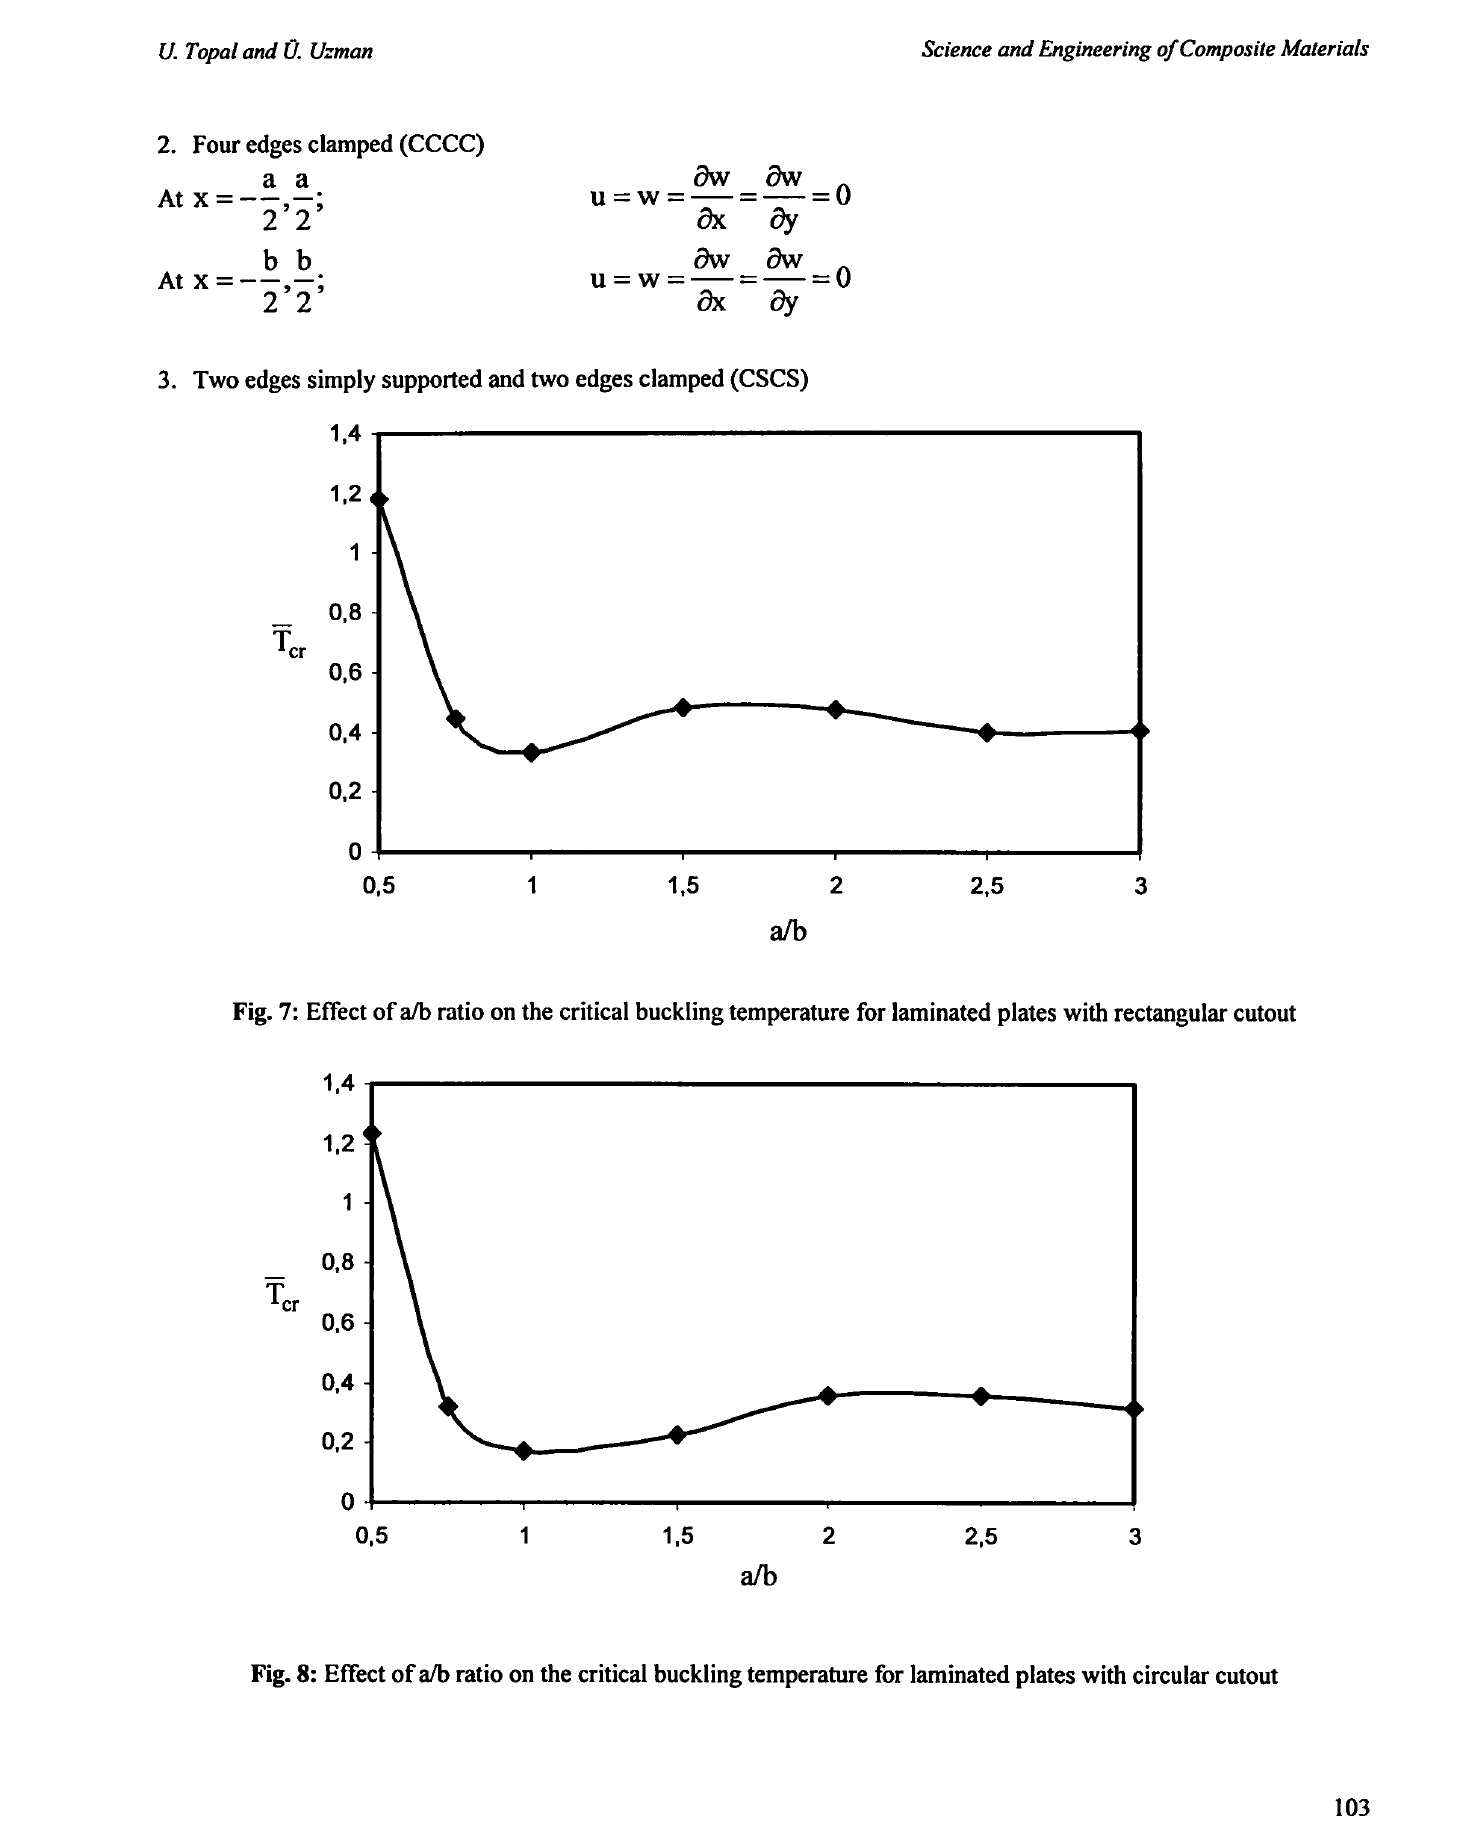
Fig. 8: Effect of a/b ratio on the critical buckling temperature for laminated plates with circular